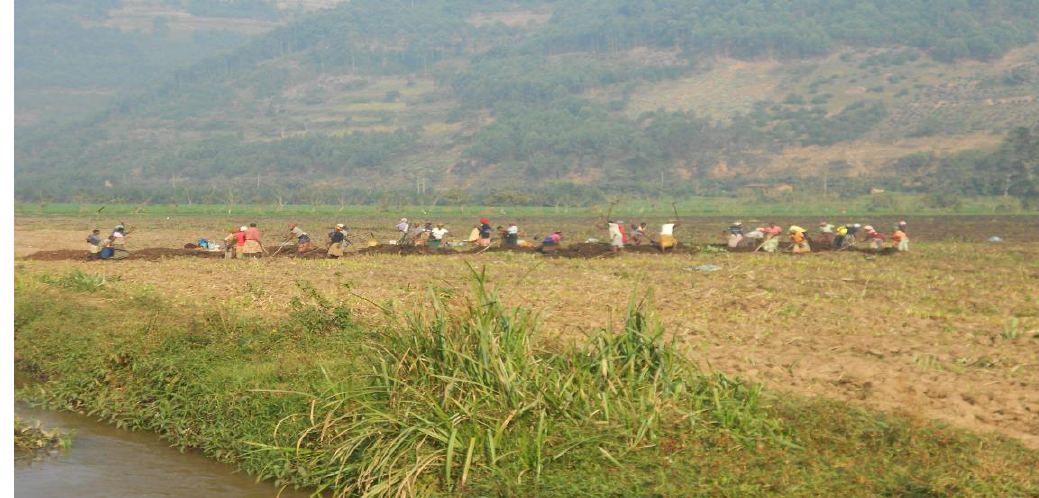
Fig. 2. Community members tilling one of the wetlands for crop cultivation in the Western Region (Barakagira, 2013)